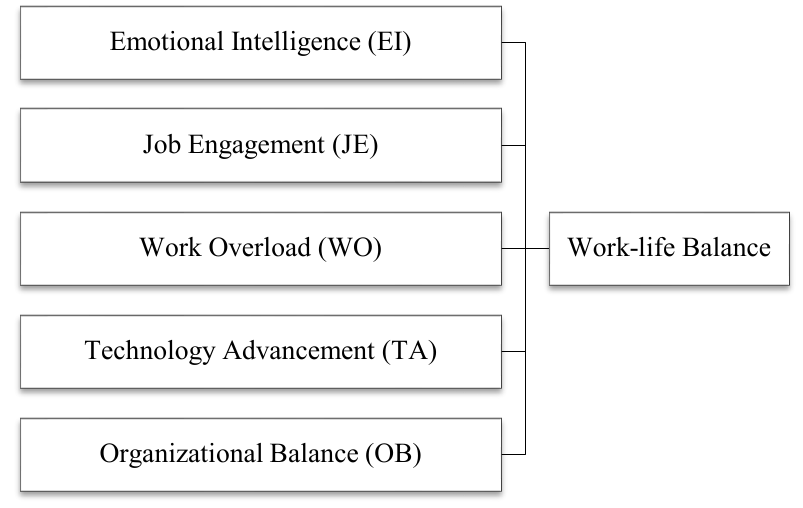
Fig. 2. Individual, Organizational and Environmental Factors Affecting Work-Life Balance (Kumarasamy et al .,